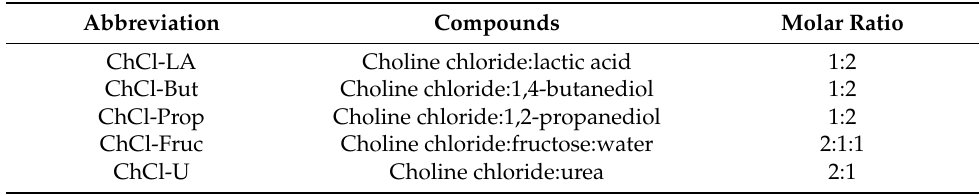
Table 1. Composition and the molar ratio of the NADES evaluated in this